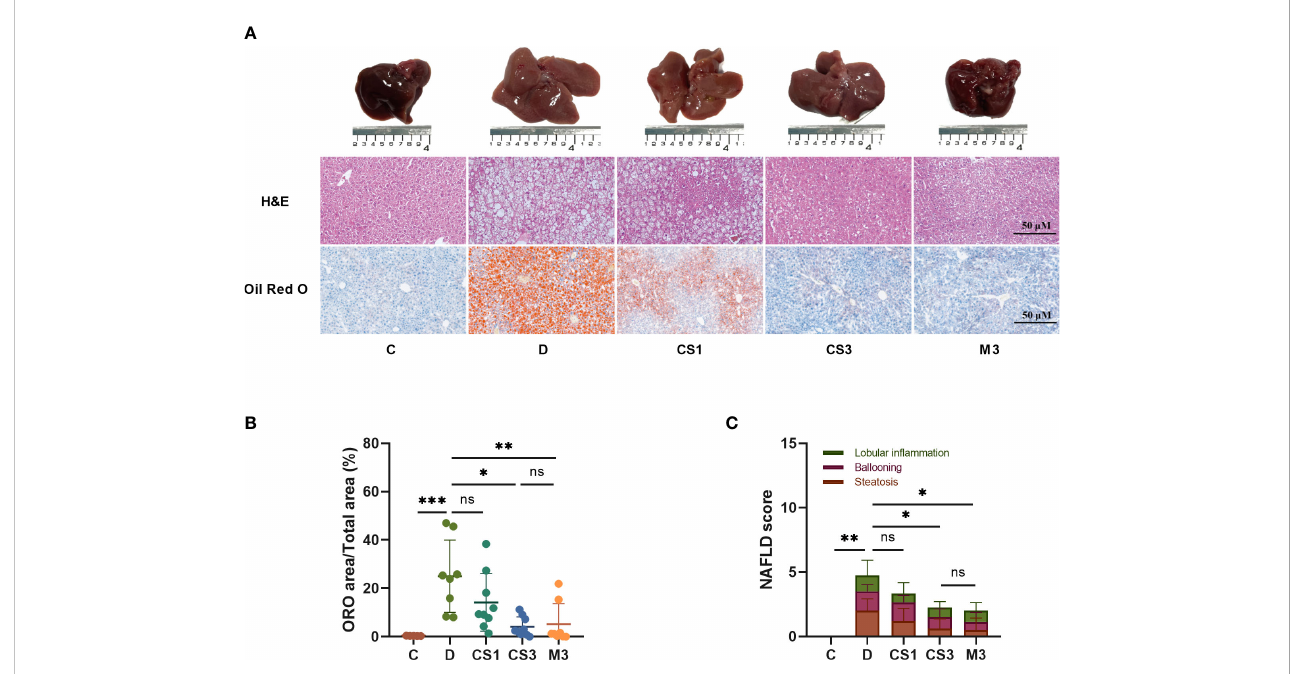
FIGURE 4 CS271011 alleviated liver steatosis and hepatic lipid accumulation. (A) Representative images of morphological differences in H&E staining and Oil red O staining of liver tissue among fi ve different groups. (x20 magni fi cation, scale bars= 50 µm); (B) Quantitative analysis of Oil red O staining; (C) NAFLD score changes in different groups of animals (C: n=5; D: n=8; CS1: n=9; CS3: n=9; M3: n=8). All data are presented as the mean ± SD. *p < 0.05, **p < 0.01, and ***p < 0.001 represent data vs. DIO controls; ns, not signi fi cant. C, chow diet control group (n=5); D, DIO control group (n=8); CS1, CS271011 1 mg/kg group (n=9); CS3, CS271011 3 mg/kg group (n=9); M3, MGL-3196 3 mg/kg group (n=8); ORO, Oil red O; NAFLD, Non-alcoholic fatty liver